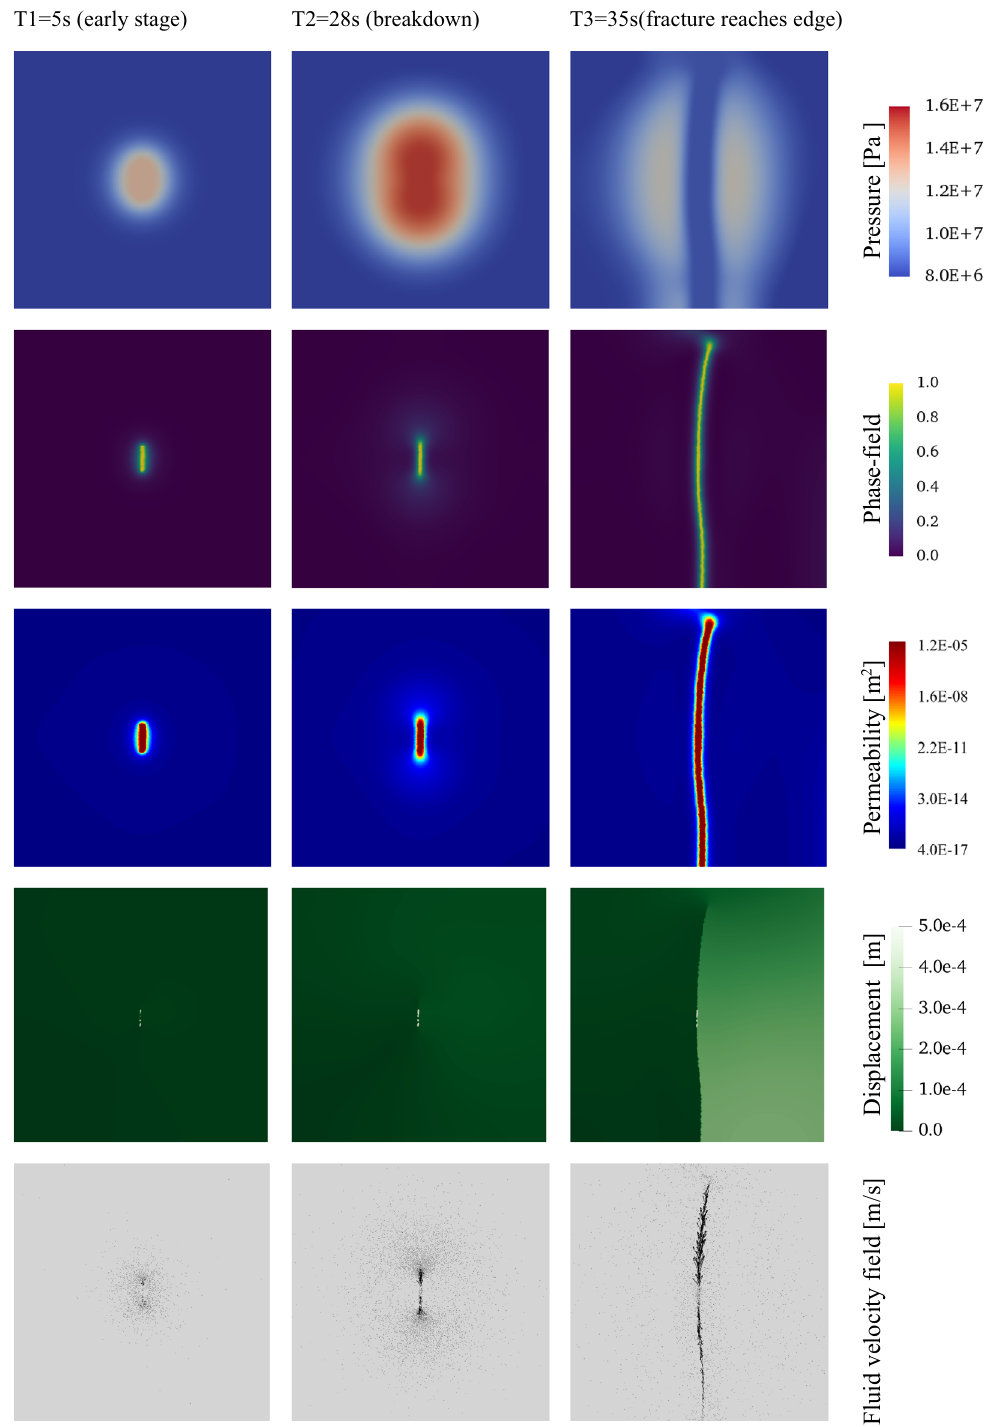
Figure 5. Contour plots for four different variables corresponding to fracture propagation at different simulation time steps (T1-T3). Continuous water injection leads to pressure buildup to the breakdown pressure (T2). The remaining energy in the system drives the fracture